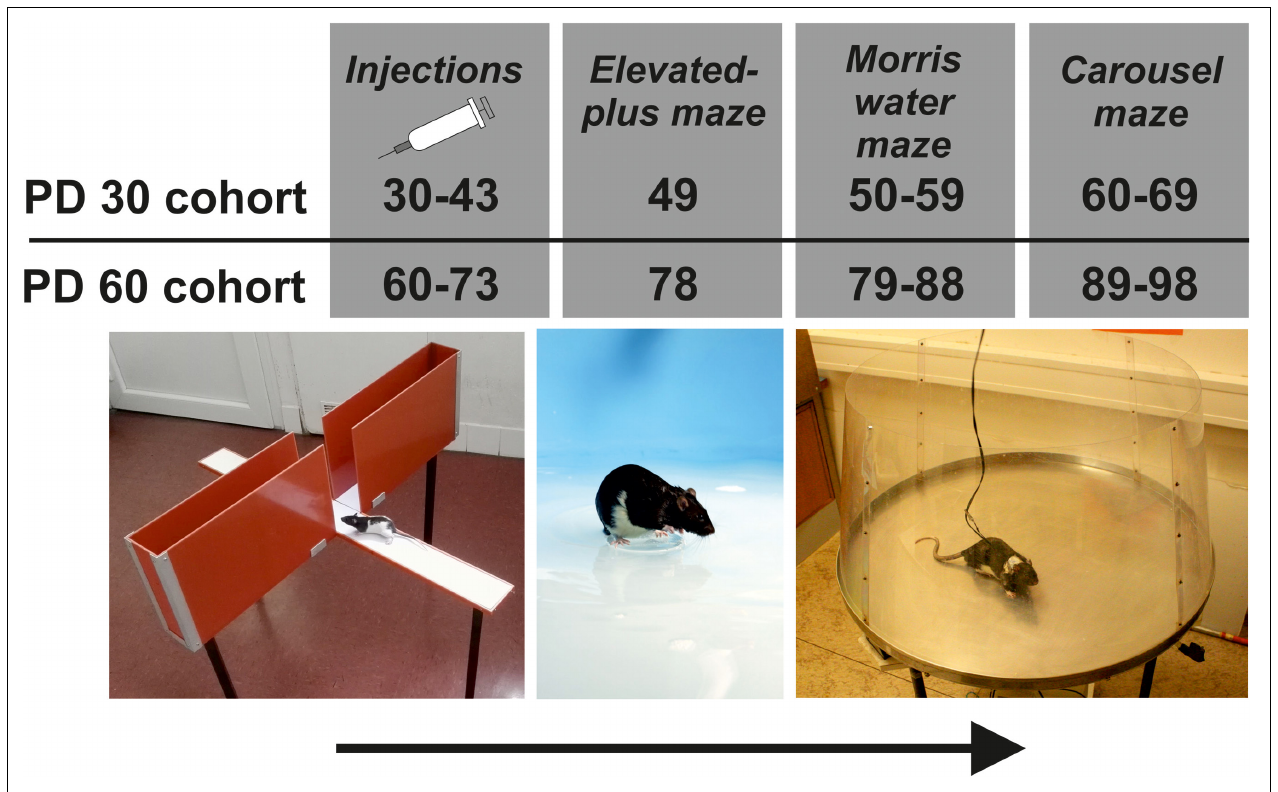
FIGURE 1 | Schematic diagram of the experimental